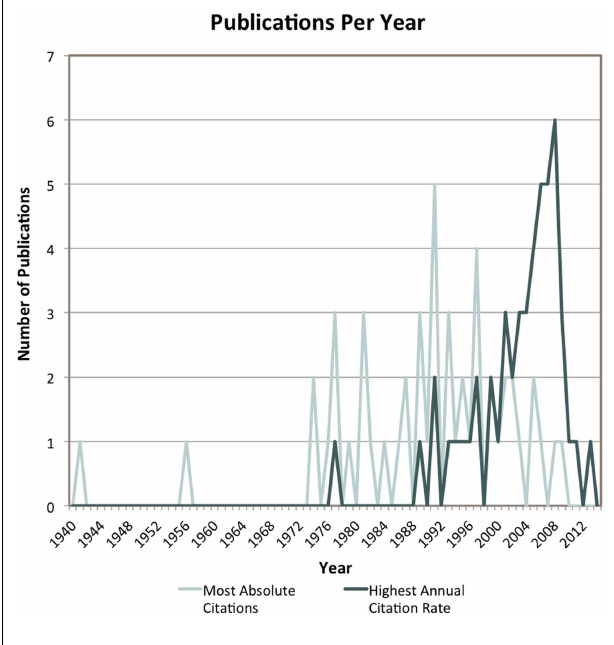
FIGURE 2 | Publication year of each of the articles that comprise the two citation cohorts .